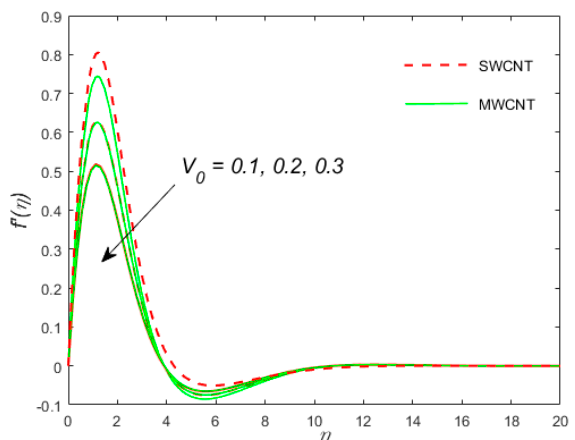
Figure 3. The variation of the velocity distribution profile f’ ( η ) for the case of SWCNT and MWCNT versus the similarity variable for the distinct values of the magnetic parameter ( M ).